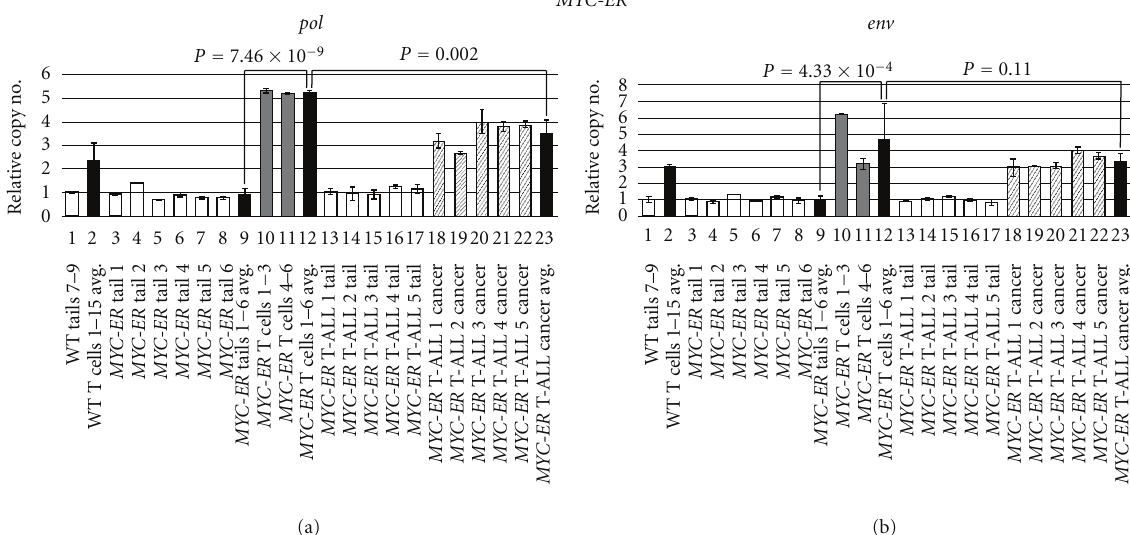
Figure 5: ZFERV amplifications in MYC-ER zebrafish. Phenotypically normal ( n = 6) or T-ALL + ( n = 5) MYC-ER fish were tested by qPCR of pol (a) and env (b). White bars display tail DNA from single normal (lanes 3–8) or diseased (lanes 13–17) fish. MYC-ER tails had similar copy number to each other (compare lanes 3–8 and 13–17) and to WT Tails 7–9 (lane 1). T cells pooled from groups of 3 normal MYC-ER fish (gray bars) showed ZFERV amplification; higher gains were seen in MYC-ER than WT T cells (lane 2 versus 12; P values 5.86 × 10 − 4 for pol , 0.15 for env ). T cells showed 4- to 5-fold higher ZFERV copy than matched tails (lane 9 versus 12). Diagonally hatched bars depict amplifications in T-ALL cells from 5 MYC-ER fish (lanes 18–22). Cancer ZFERV levels were well above paired tails (compare lanes 13–17 to 18–22). Slightly lower gains were seen in cancerous than non-malignant MYC-ER T cells (lane 12 versus 23); this reached statistical confidence for pol , but not env . Other details are as listed in Figure 3’s legend.